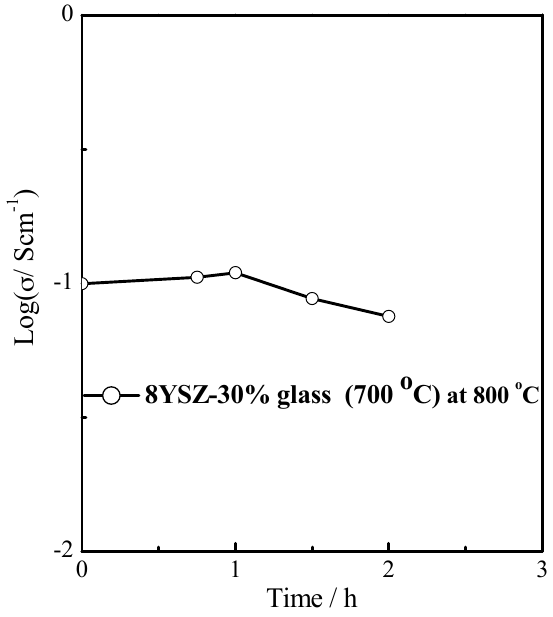
Figure 4. The variation of conductivity of 8YSZ-30% glass (700 °C) with time in nitrogen atmosphere at 800 °C.